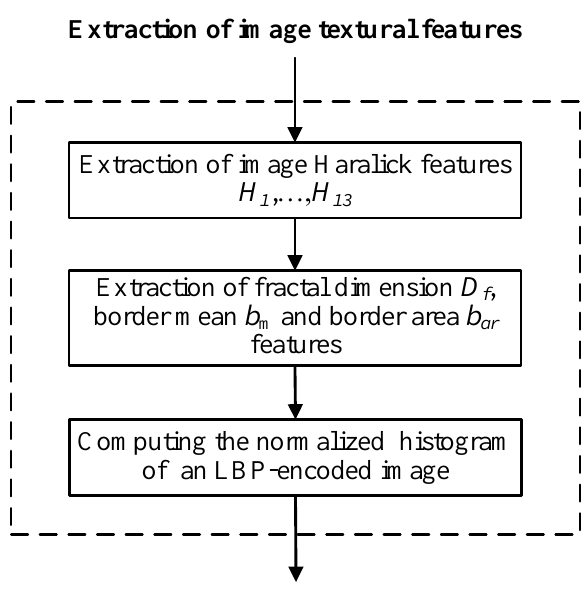
Figure 7. Flowchart of the textural features selected for biofuel classification. Other SFTA textural features are the border mean value b m and the border area b ar . The b m is evaluated as the average brightness of the image I Y on the borders of white